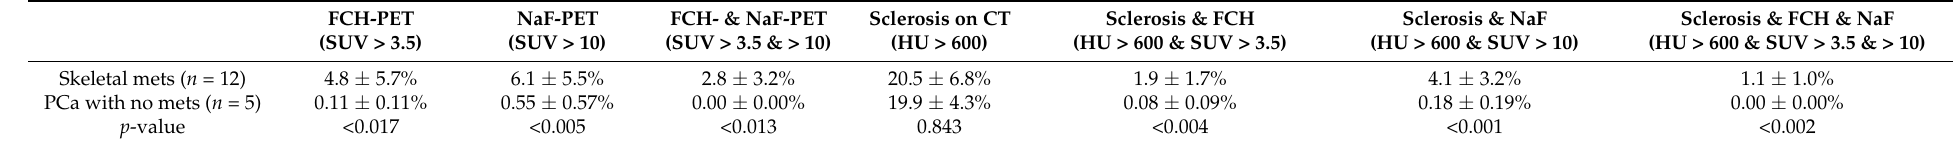
Table 2. Results. Pathologic PET/CT volumes as percentages of the skeletal volumes (when HU > 150 on CT) are presented. Pathologic volumes for FCH (SUV > 3.5), NaF (SUV > 10) and when both are pathologic on PET studies are shown. Sclerosis is measured from CT (HU > 600) volume and calculated from FCH PET/CT. Similarly, simultaneous sclerosis and pathologic volumes for both FCH and/or NaF are shown. The volumes are shown for patients with bone metastases (M) and for control prostate cancer patients with no skeletal metastases (N). The amount of sclerosis does not statistically differ in these patient groups. All pathological volumes differ statistically significantly from each other between M and N